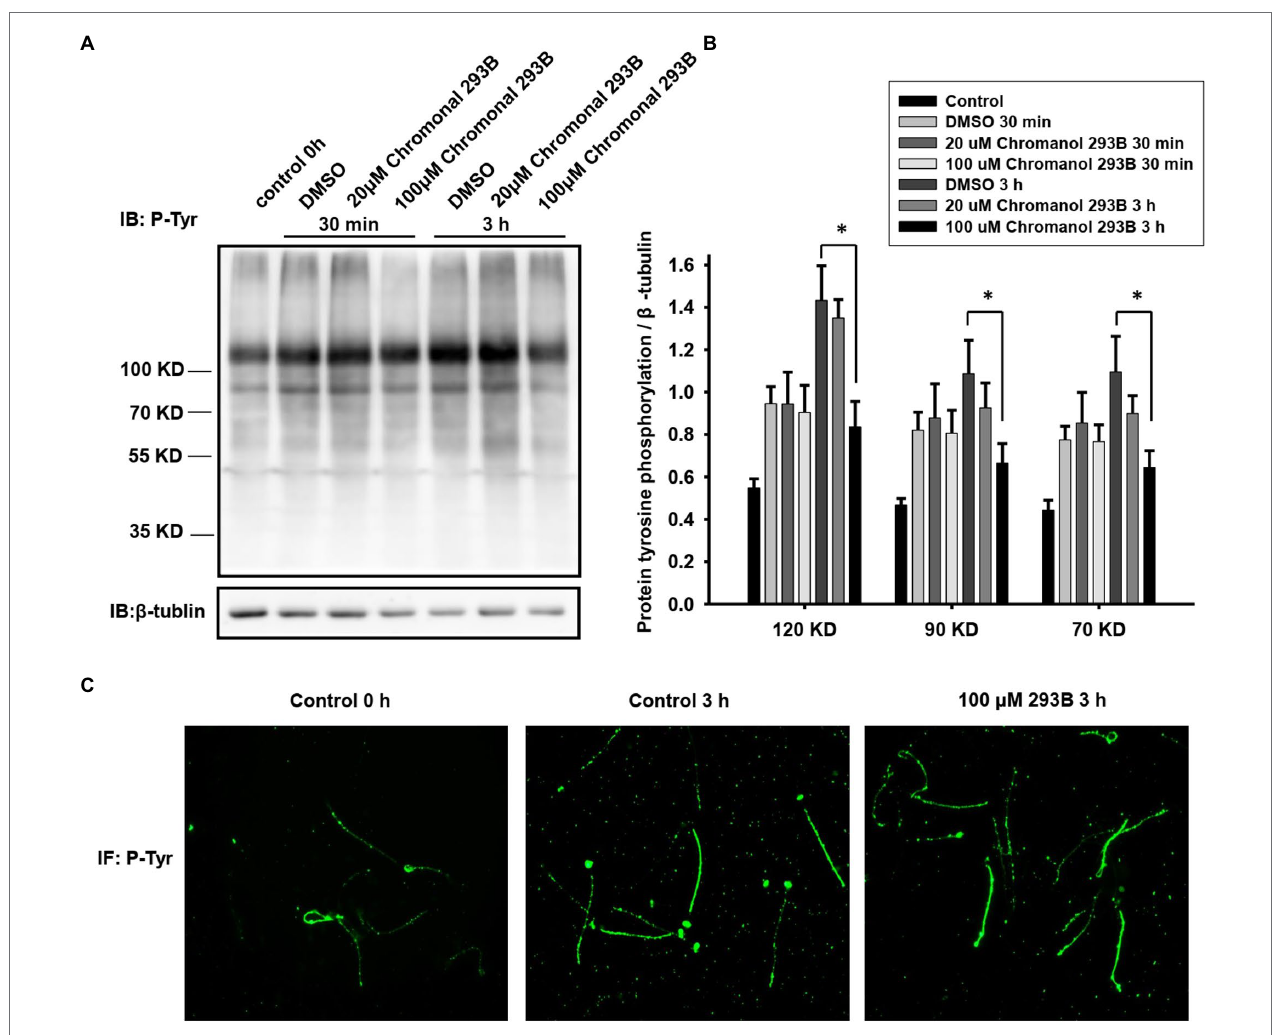
FIGURE 3 | Effect of chromanol 293B on protein tyrosine phosphorylation during human sperm capacitation. (A) Western blotting results showing the effect of chromanol 293B on protein tyrosine phosphorylation during human sperm capacitation. Sperm before capacitation incubation were used as the control group. Other sperm were treated with the vehicle control (DMSO), 20 μ M chromanol 293B, and 100 μ M chromanol 293B under capacitated conditions for 30 min and 3 h. Thereafter, sperm were lysed and then the proteins were resolved using 10% SDS-PAGE. Protein tyrosine phosphorylation was detected using a primary anti- phosphotyrosine antibody by Western blotting. Subsequently, the blot was stripped and probed with an anti- β -tubulin antibody as a loading control. The figure is representative of 6 separate experiments. The full uncropped immunoblots was provided in the supplementary data ( Supplementary Figure 2 ). (B) The ratio of protein tyrosine phosphorylation levels to that of the loading control, β -tubulin. Values represent the means ± SEM of 6 experiments. For 100 μ M chromanol 293B group compared to vehicle control group, * p < 0.05. (C) Indirect immunofluorescence of protein tyrosine phosphorylation in human sperm before and after capacitation for 3 h. The figure is representative of 3 separate